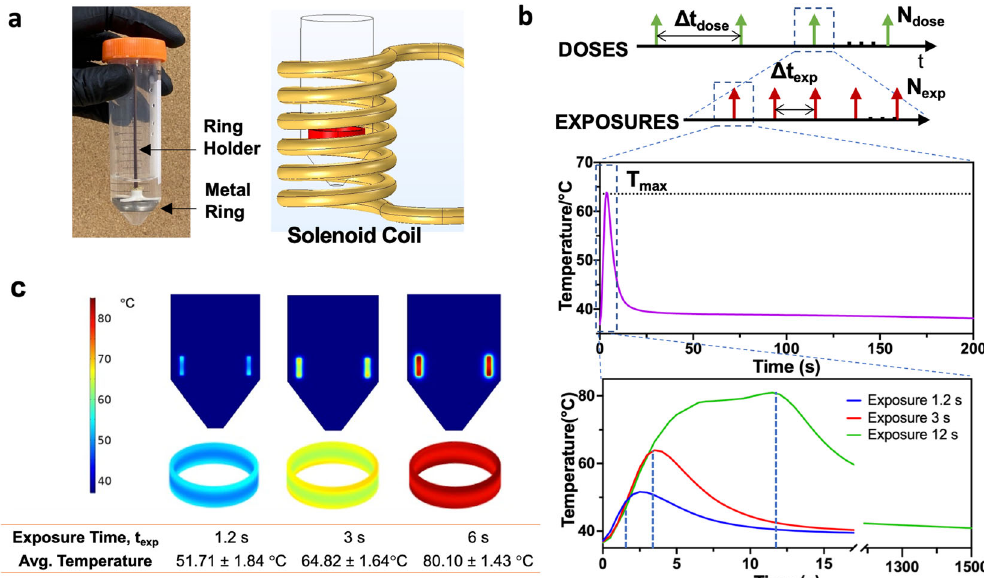
Fig. 1 Simulation and measurements of intermittent alternating magnetic fi eld (iAMF) heating. The experimental set-up consisted of a stainless-steel ring with bio fi lm in media in a 50-mL tube and held in place by a plastic holder ( a left image). The tube is placed in a solenoid coil ( a right image). b shows a representation of the iAMF dosing scheme. An iAMF treatment was organized as a series of doses separated by hours ( Δ t dose , panel top). N dose was the number of doses in the whole treatment. Each dose is composed of multiple short-term exposures of AMF ( N exp ). During the iAMF exposure, the AMF was on for several seconds of ( t exp ), and the rings were heated to the targeted temperature ( T max ). The exposures were delivered at intervals ( Δ t exp ) to allow the temperature to return to baseline ( b middle image). Temperature vs. time for the ring upon AMF exposure to a T max of 50, 65, and 80 °C is shown c . Simulated AMF heating of a metal ring for different exposure times depicts spatial temperature variation on the surface, and minimal heating of surrounding media. The mean and standard deviation of the temperature are